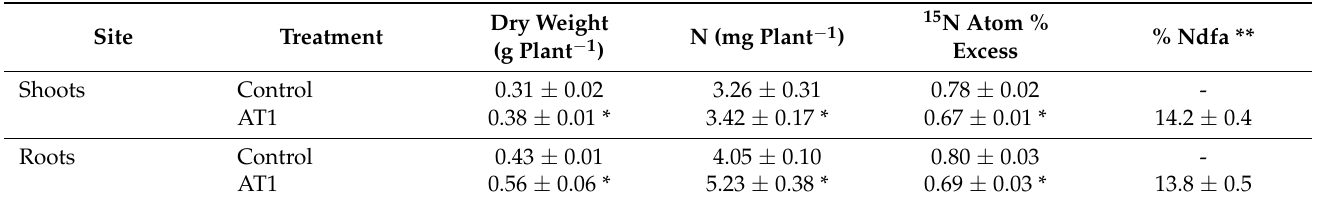
Table 5. Effects of Bradyrhizobium sp. AT1 inoculation on dry weight and N nutritional parameters of sweet potato (cv. Beniazuma) 5 months after transplantation.